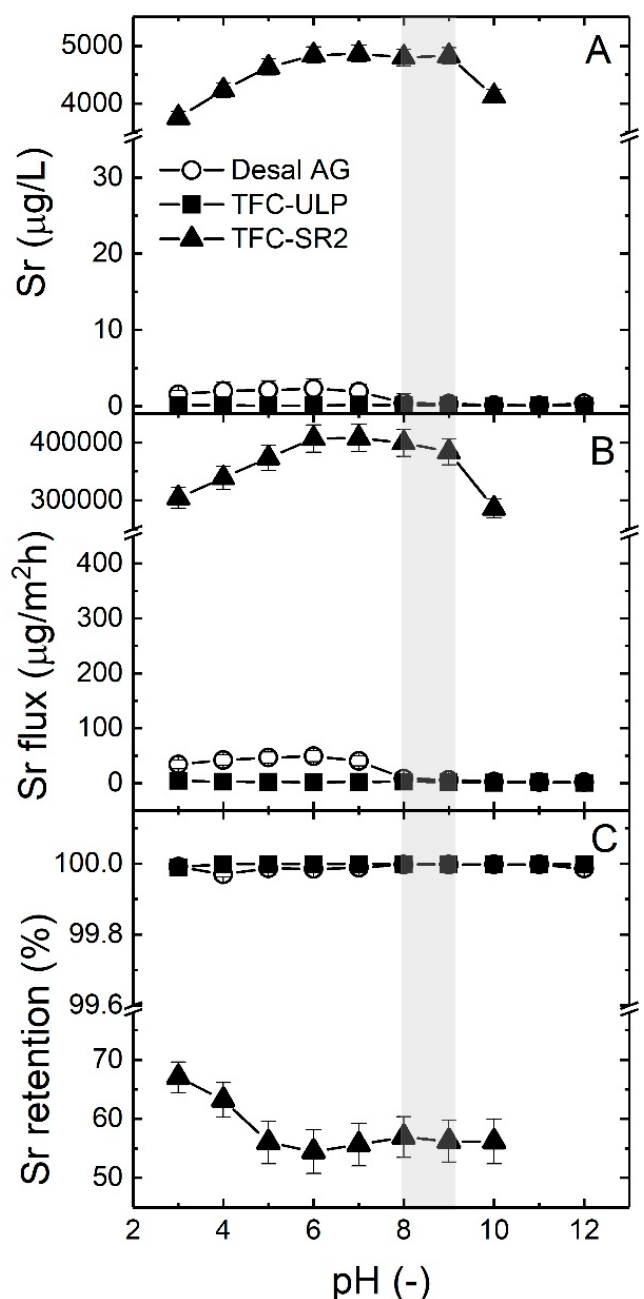
Figure 10. ( A ) Sr permeate concentration, ( B ) Sr flux and ( C ) Sr retention of three membranes as a function of the pH (3–12) of groundwater sample 5. The grey area represents the pH range of groundwater samples 1–5. The applied pressure was 10 bar. Data adapted from [69].